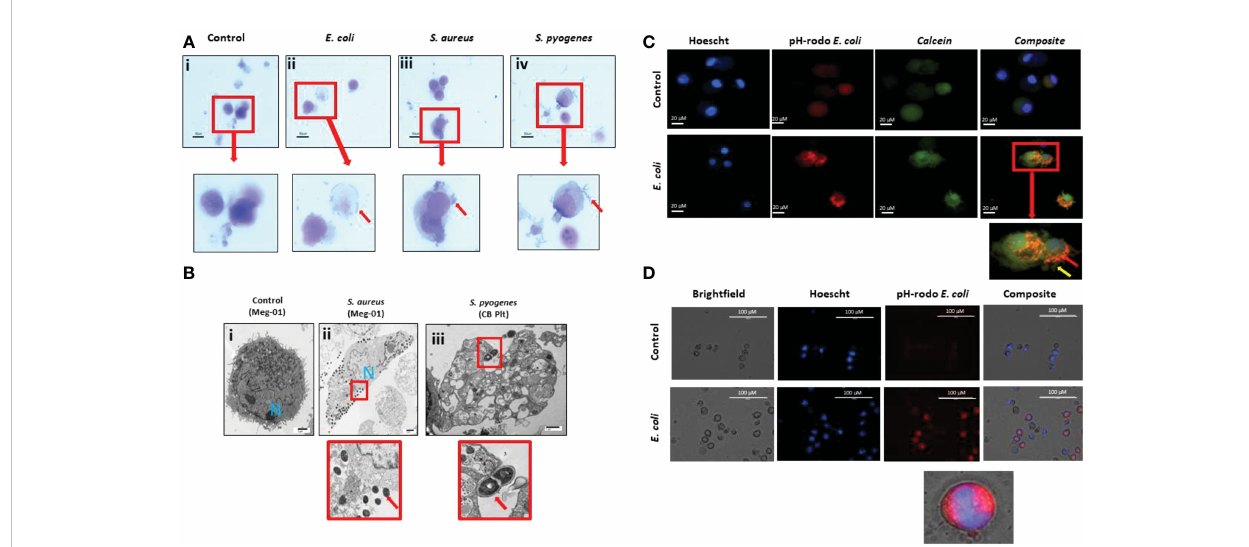
FIGURE 4 MKs interact with pathogens. (A) Meg-01 cells were co-incubated with E. coli , S. aureus , and S. pyogenes . Light microscopy with diff-quick staining shows that bacteria are associated with the cytoplasm and cell membrane of the cells. (B) Transmission electron microscopy of both Meg-01 and SC MKs exhibiting bacterial association with the cell membrane as well as internalization into vacuoles within the cytoplasm. Panel i is a control Meg-01 cell, while panel ii is a Meg-01 cell that was co-incubated with live S. aureus. Panel iii is from a SC MK culture co-incubated with live S. pyogenes showing association of the bacteria with a platelet cell membrane. (C) SC MKs were co-incubated with live pHrodo-conjugated bacteria. This is a representative image of a control cell along with a cell co-incubated with E. coli . (D) Meg-01 cells were co-incubated with pHrodo-conjugated live E. coli and then imaged. Notice the lack of rod-shapes in the Meg-01 cell (D) and diffuse cytoplasmic fl uorescence in comparison with the SC MKs (C) . Bacteria, red arrow; pseudopods, yellow